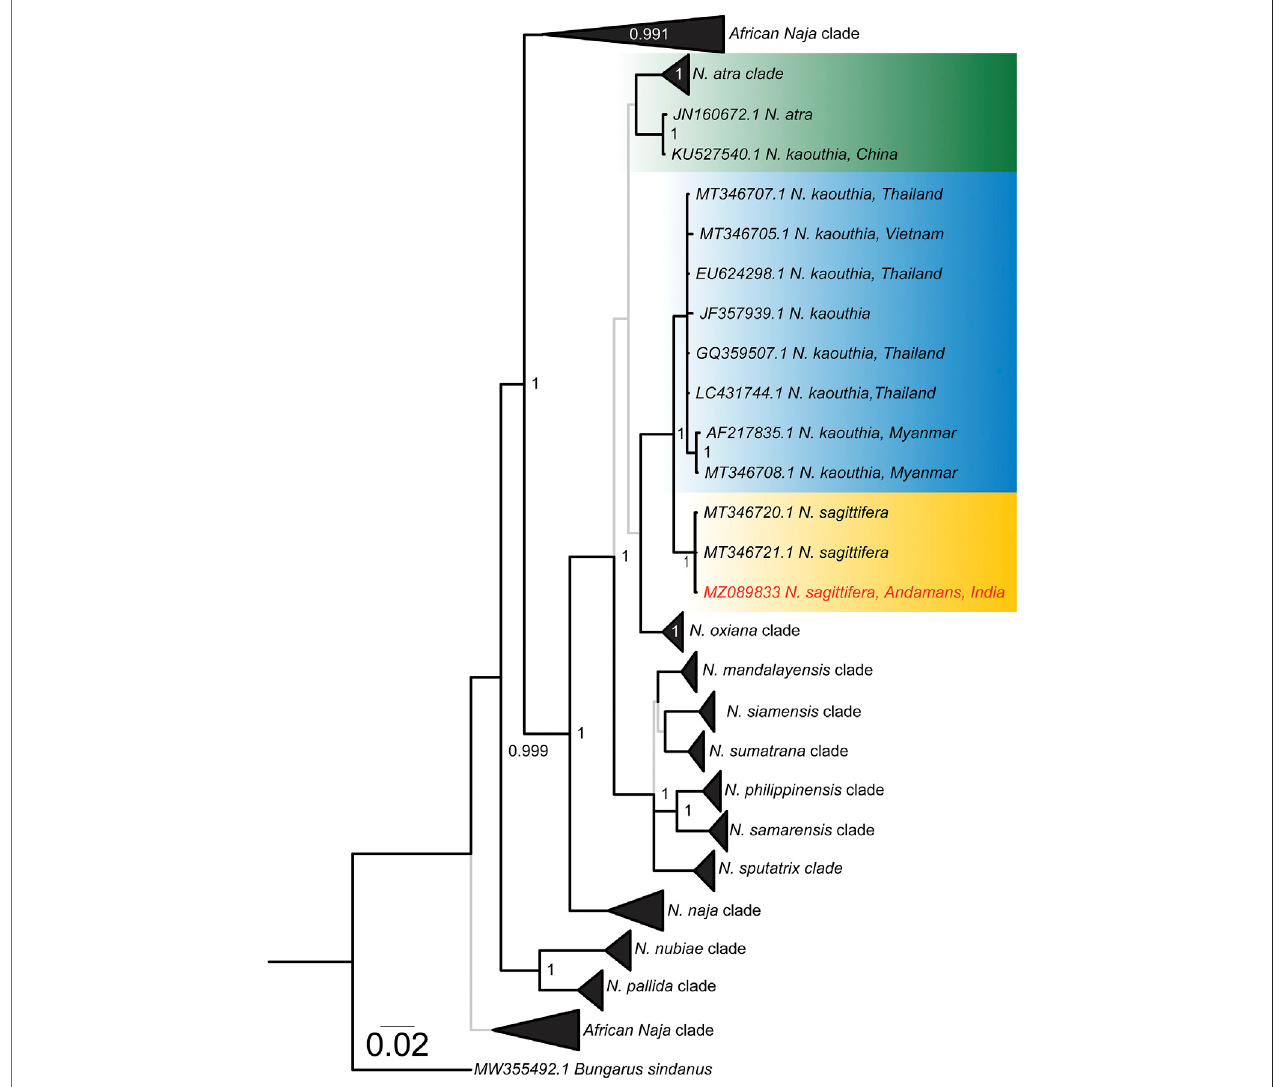
FIGURE1| Bayesiancyt b phylogenyof Naja species.Lineagesofinteresthavebeenshowninuniquelycolouredboxesandtheaccessionnumberoftheindividual sequenced in this study has been highlighted in red. Branches with superior (BPP ≥ 0.95) and relatively inferior (BPP ≤ 0.95) node support are shown in thick black and thin grey lines, respectively. Branch lengths are scaled by the number of nucleotide substitutions per